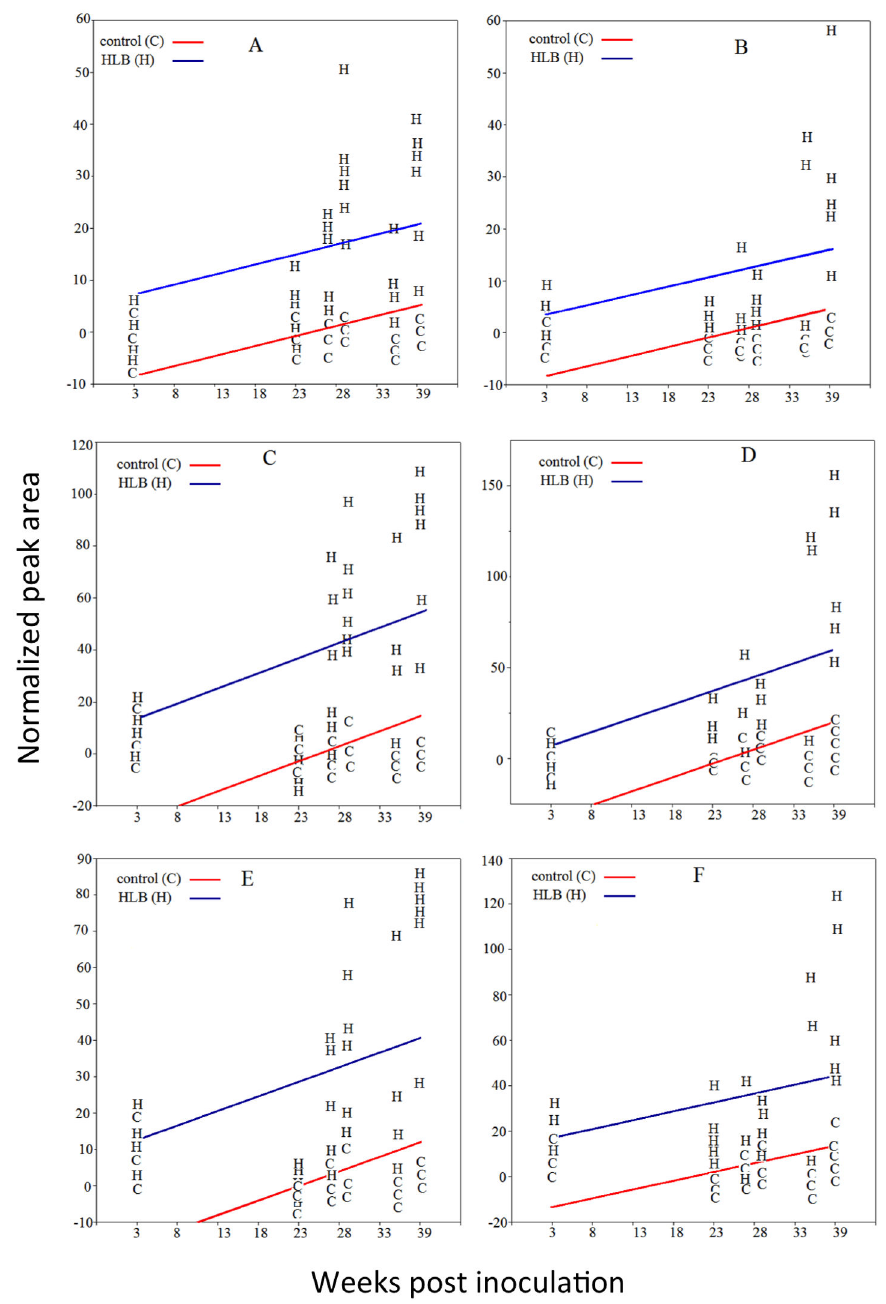
Figure 6. Relative amounts versus time (week) of different citrus leaf metabolites from controls and C Las-inoculated trees. A ) unknown 6 in ‘Valencia’ leaves; B ) unknown 6 in ‘Hamlin’ leaves; C ) unknown 7 in ‘Valencia’ leaves; D ) unknown 7 in ‘Hamlin’ leaves; E ) unknown 9 in ‘Valencia’ leaves; F) unknown 9 in ‘Hamlin’ leaves.